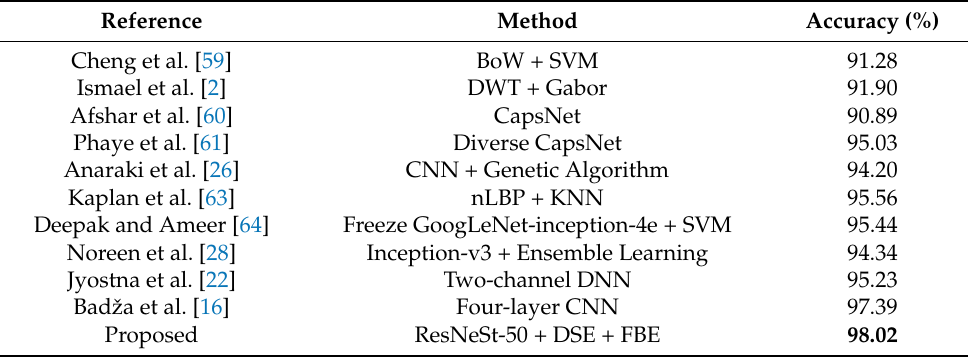
Table 9. Comparison between the proposed and existing state-of-the-art